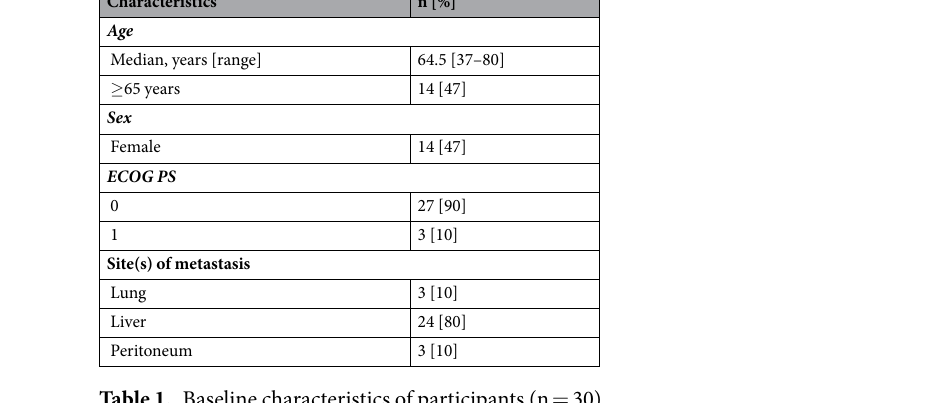
Table 1. Baseline characteristics of participants (n =